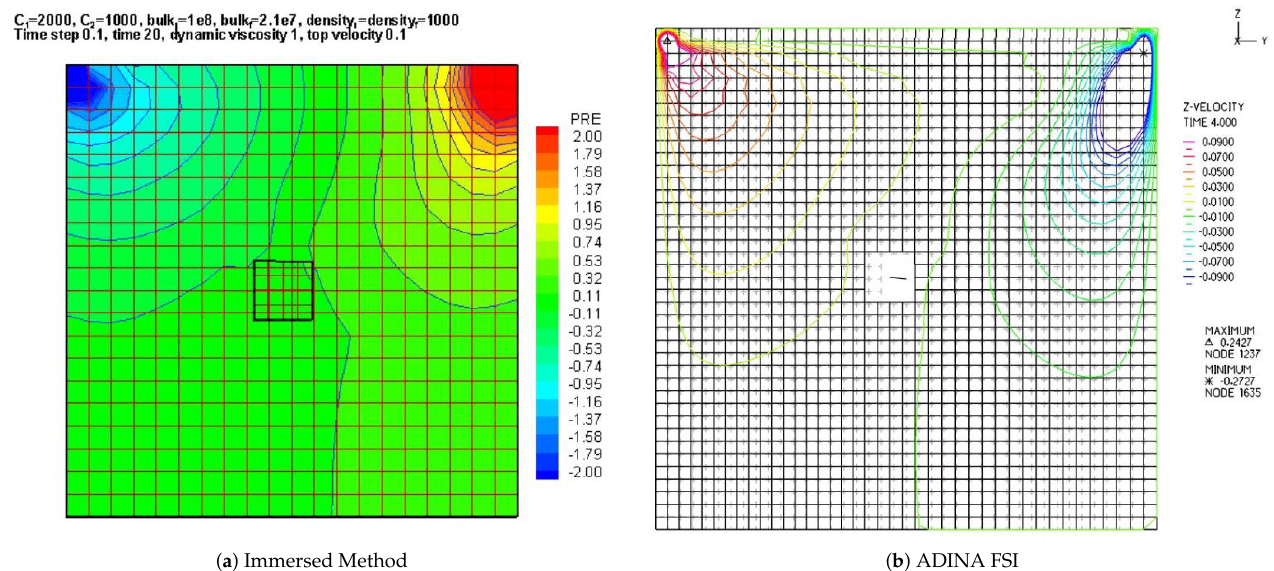
Figure 8. Snapshots of results from the immersed continuum method and the ADINA FSI